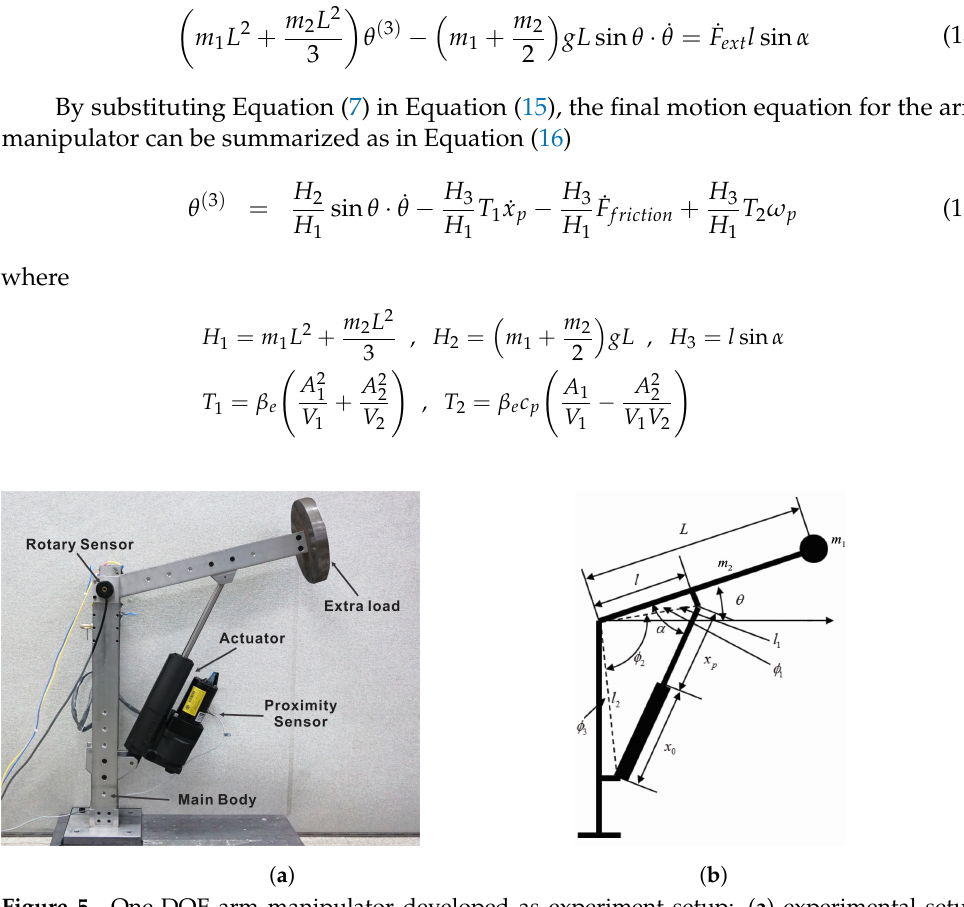
Figure 5. One-DOF arm manipulator developed as experiment setup: ( a ) experimental setup, ( b ) schematic